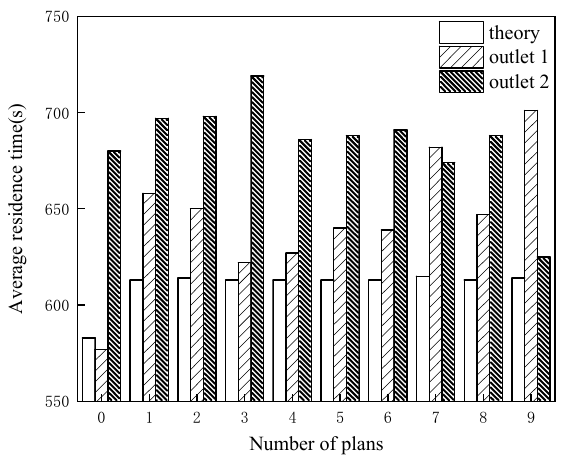
Figure 7. Average residence time of each program.